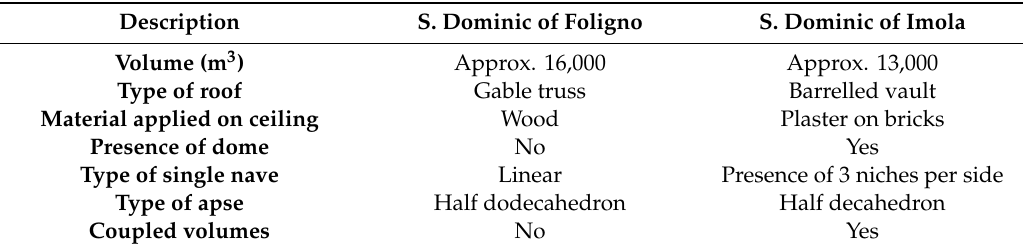
Table 1. Architectural characteristics of S. Dominic of Foligno and